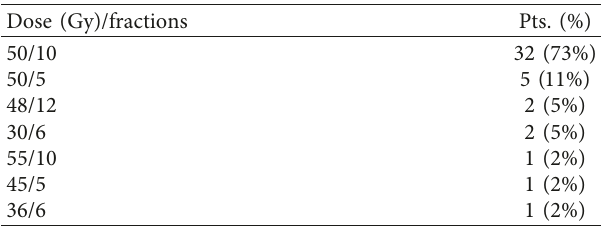
Table 2: SBRT doses and fractions.